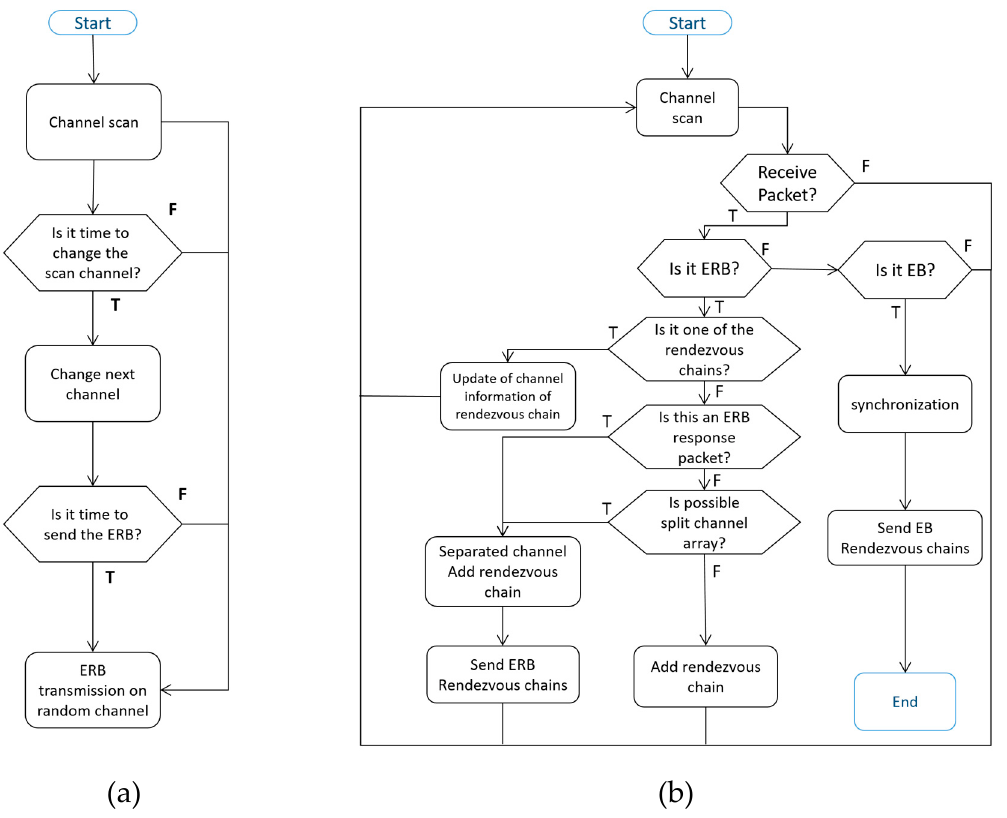
Figure 7. DRL–TSCH Flow Chart ( a ) Channel change and ERB packet transmission during channel scan ( b ) Operation when receiving ERB during channel scan.